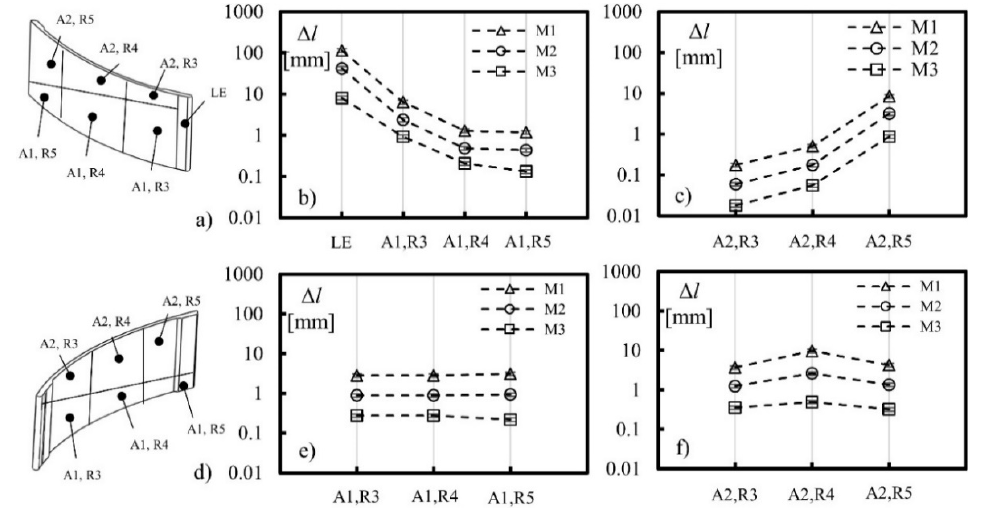
Figure 6. Rotor wear: ( a ) coordinates of the patches on the pressure side and material loss, ( b ) on the axial section A1 and ( c ) on the axial section A2; ( d ) coordinates of the patches on the suction side and material loss, ( e ) on the axial section A1 and ( f ) on the axial section A2. R3, R4 and R5 are the radial annular areas, LE is the leading edge.